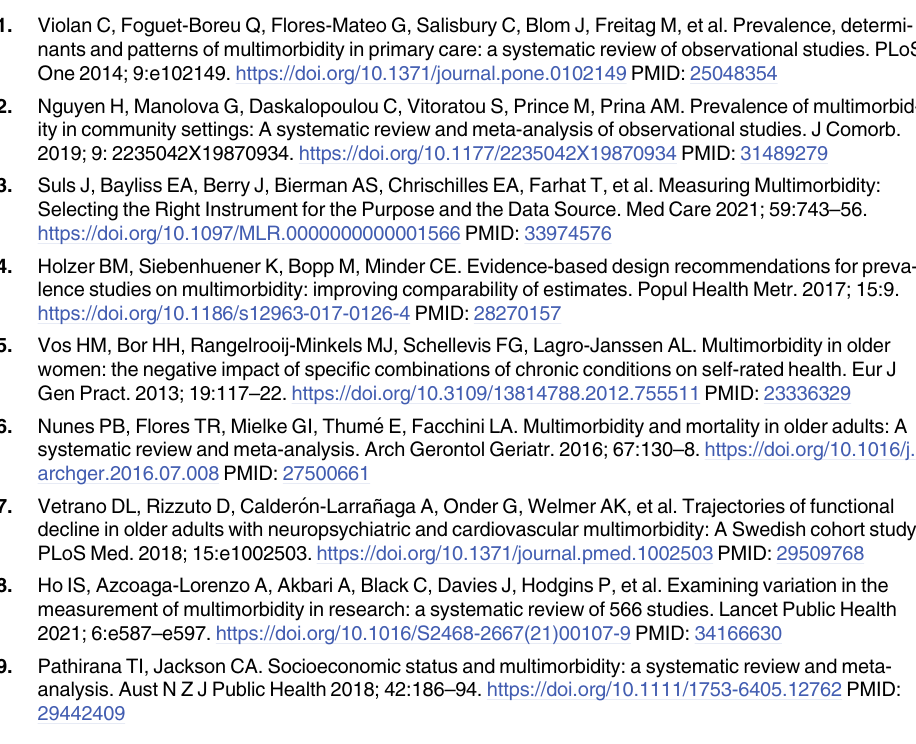
S2 Table. Frequencies of dyads and triads involved in multimorbid associations across gen- der and age categories (HSM survey). S3 Table. Age and gender adjusted and fully adjusted (age, gender, education level, occupa- tion, and household income) risk of multimorbidity ( � 2 conditions), associated with urban unit and region as estimated in multiple binary logistic